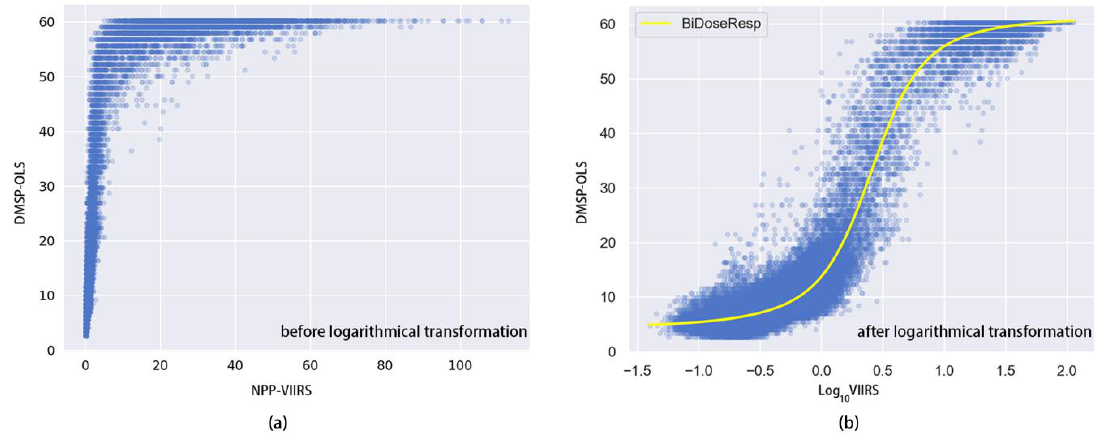
Figure 3. Scatter plot of the original NPP-VIIRS and DMSP-OLS pixel pairs in the vicarious site ( a ); scatter plot of the logarithmically transformed VIIRS and DMSP-OLS pixel pairs in the vicarious site ( b ); and, yellow curve denotes the fitted BiDoseResp model. Table 2. Candidate models.